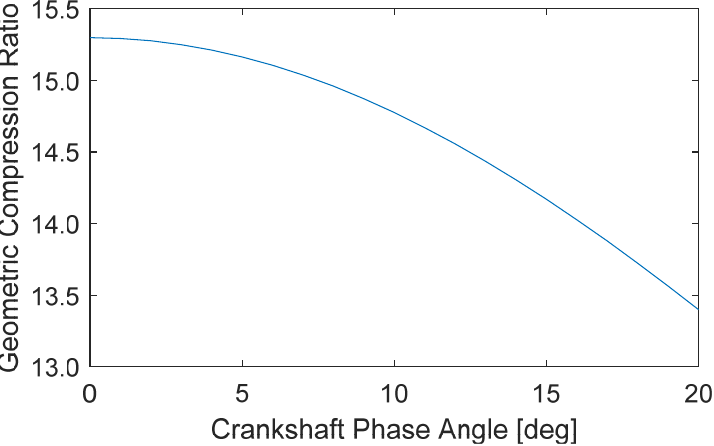
Figure 6. Effect of crankshaft phasing on geometric compression ratio.